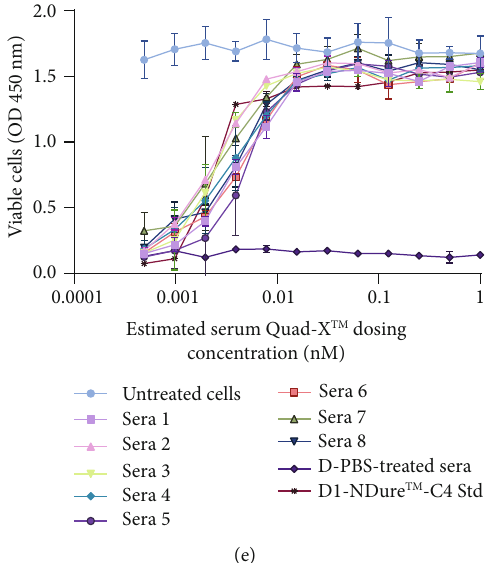
Figure 5: In vitro functional assessment of serum samples of mice treated with anti-hTNF- α drugs . (a – e) Determination of residual neutralising capacity of serum anti-hTNF- α drugs in a classical in vitro hTNF- α -induced cytotoxicity assay using a sensitised L929 cell line. (a and b) Shown are 1mg/kg and 3mg/kg Quad-X ™ -treated serum samples, respectively (Quad-X ™ -treated sera vs. D-PBS-treated sera, p < 0 : 0001 ). (c and d) Shown are 1mg/kg and 3 mg/kg Humira®-treated serum samples, respectively (Humira®-treated sera vs. D- PBS-treated sera, p = 0 : 9991 for all 1mg/kg treated sera except sera 5 ( p < 0 : 001 ) and p > 0 : 7 for 3 mg/kg treated sera 4 and 5). (e) Shown are 30mg/kg D1-NDure ™ -C4-treated serum samples ( p < 0 : 0001 for all D1-NDure ™ -C4-treated sera vs. D-PBS-treated sera). Exogenous recombinant hTNF- α at 0.3ng/mL and 1 μ g/mL actinomycin-D were used in all treatment groups except where otherwise stated. No exogenous hTNF- α and actinomycin-D were added to untreated cells and D-PBS-treated sera (nil hTNF) control groups. Quad-X ™ Std and Humira® Std represent standard known concentrations of the drugs. The results shown are the mean ± SD ( n = 2 with three replicates per experiment). Results were analysed statistically using a two-way ANOVA with multiple comparison post hoc test ( p > 0 : 05 is considered not signi fi